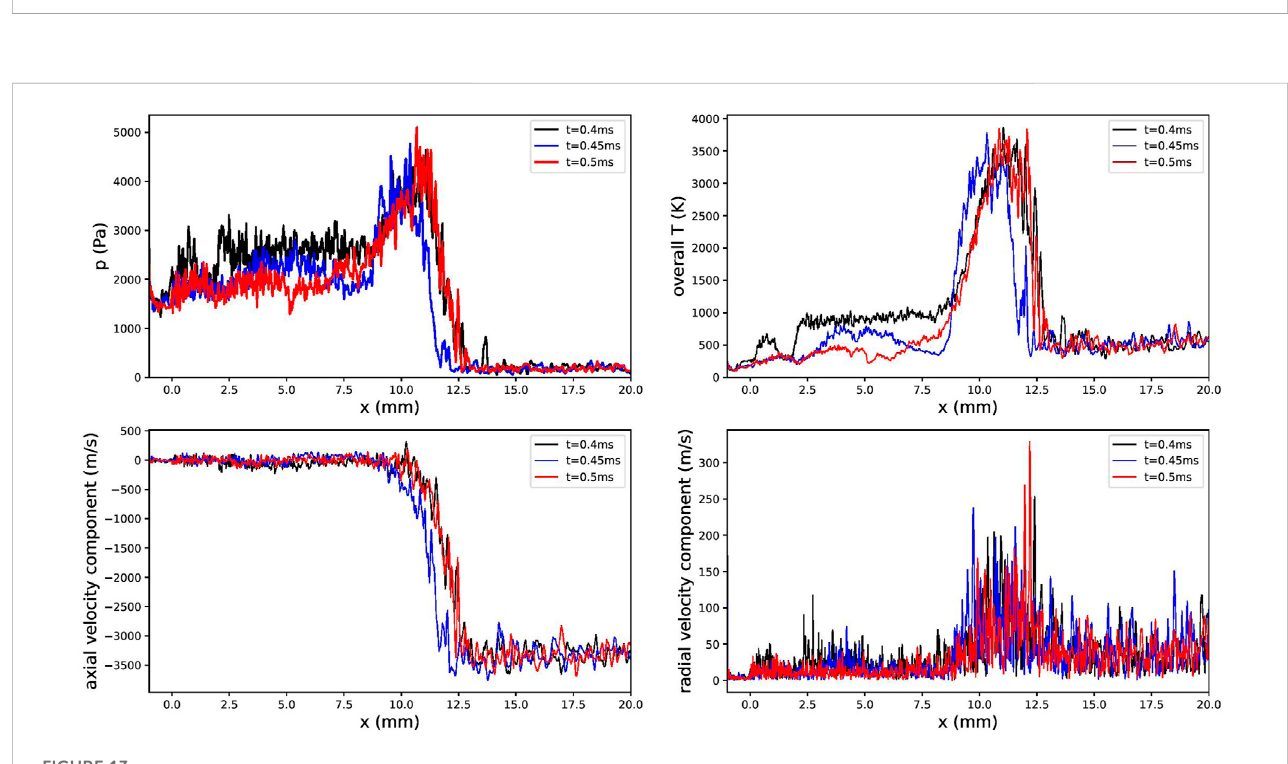
Physical properties along the symmetry axis for the MPPIC